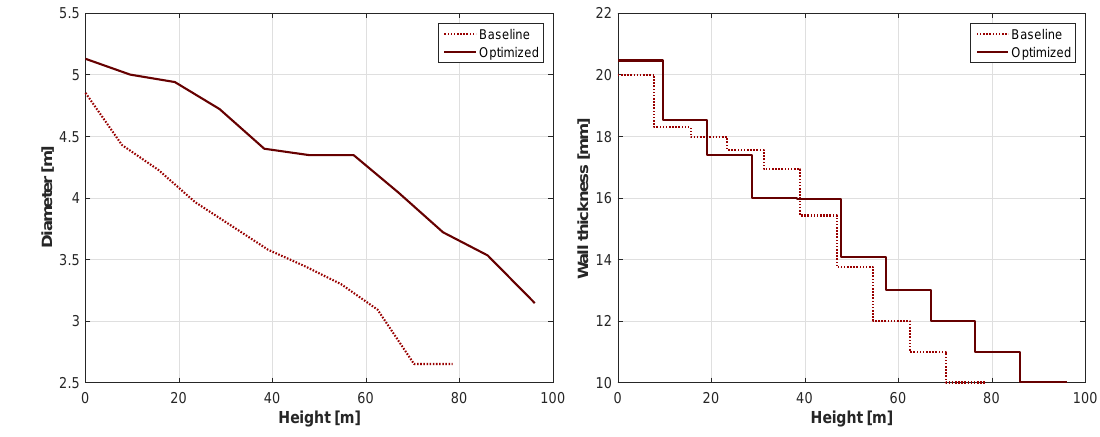
Figure 6. Tower outer diameter and wall thickness distributions of the baseline and the optimized 2.2MW wind turbines.